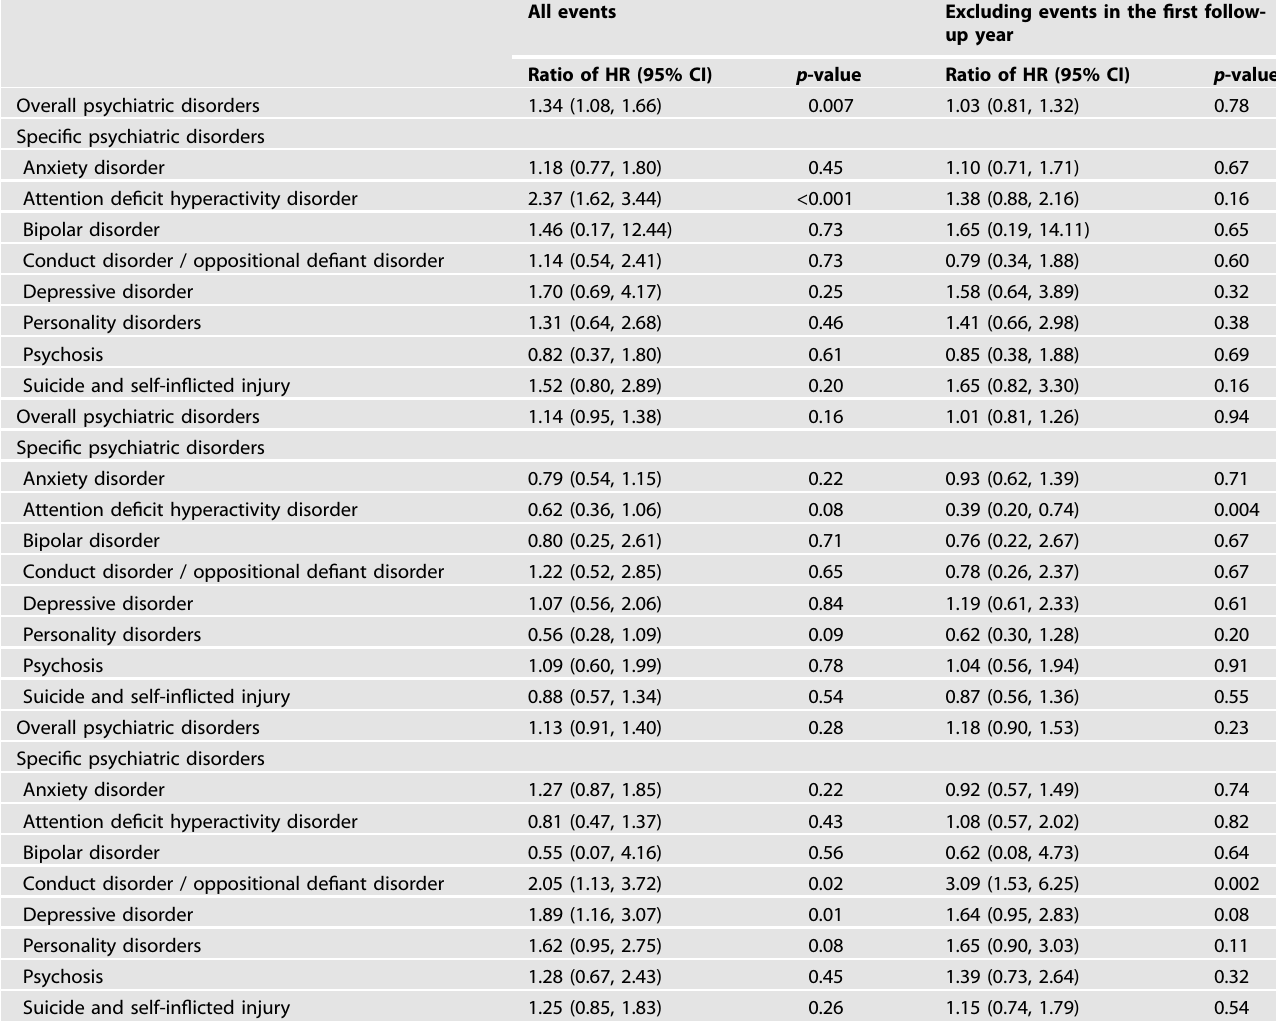
Table 3. a. Comparison of child maltreatment effect on later psychiatric disorders by age of onset ( ≥ 6 vs <6). b. Comparison of child maltreatment effect on later psychiatric disorders by gender (male vs female). c. Comparison of child maltreatment effect on later psychiatric disorders by history of childhood sexual abuse (yes vs